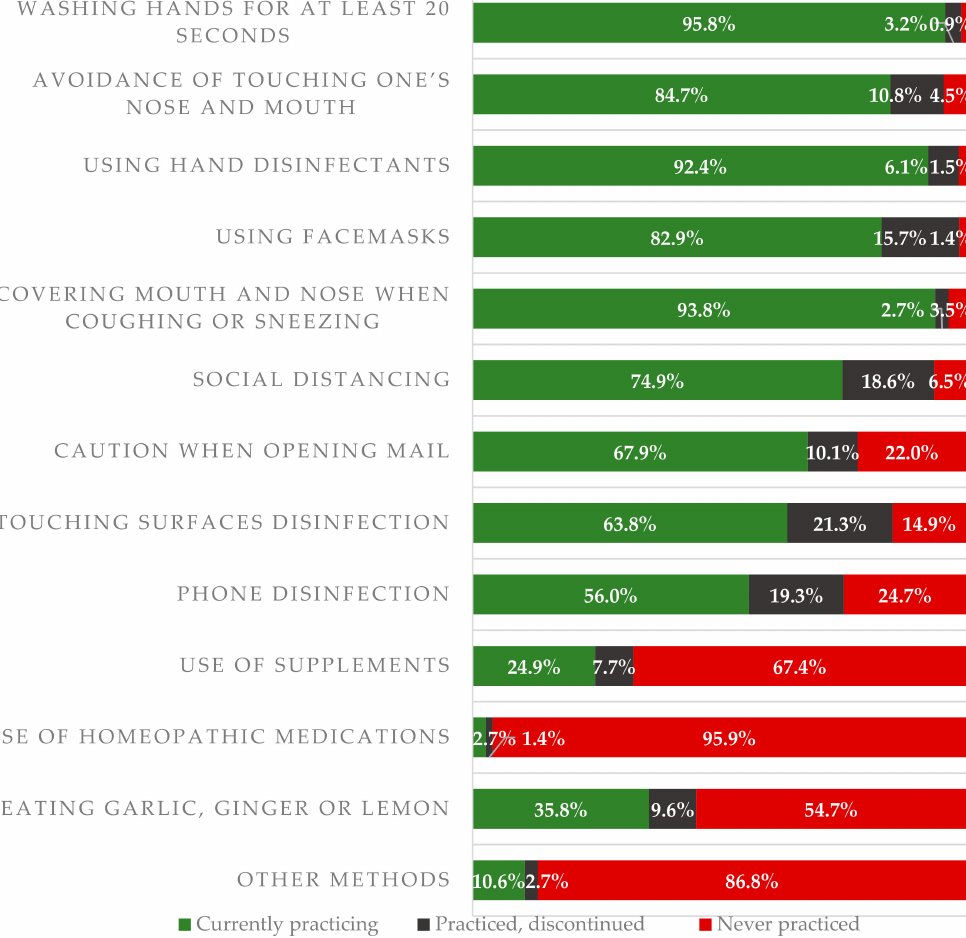
Figure 1. Methods of SARS-CoV-2 infection prevention practiced by the study